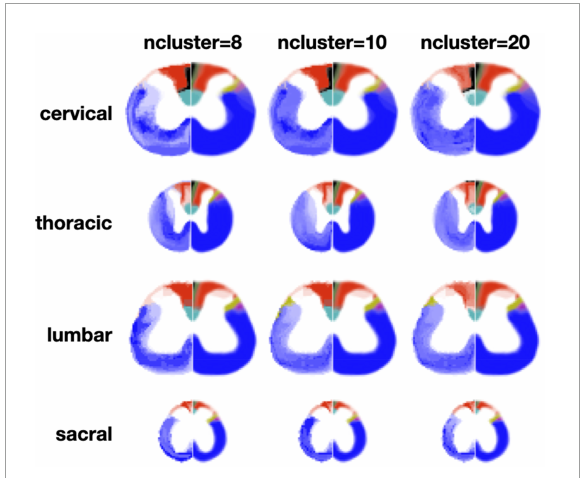
FIGURE6 Results of the region-wise clustering. Clusters are shown for 8, 10, and 20 clusters for each region after they have been registered to a reference slice within each region. The left half shows the clustering results and the right half shows the Watson atlas. The spatial scaling across regions is kept the same.